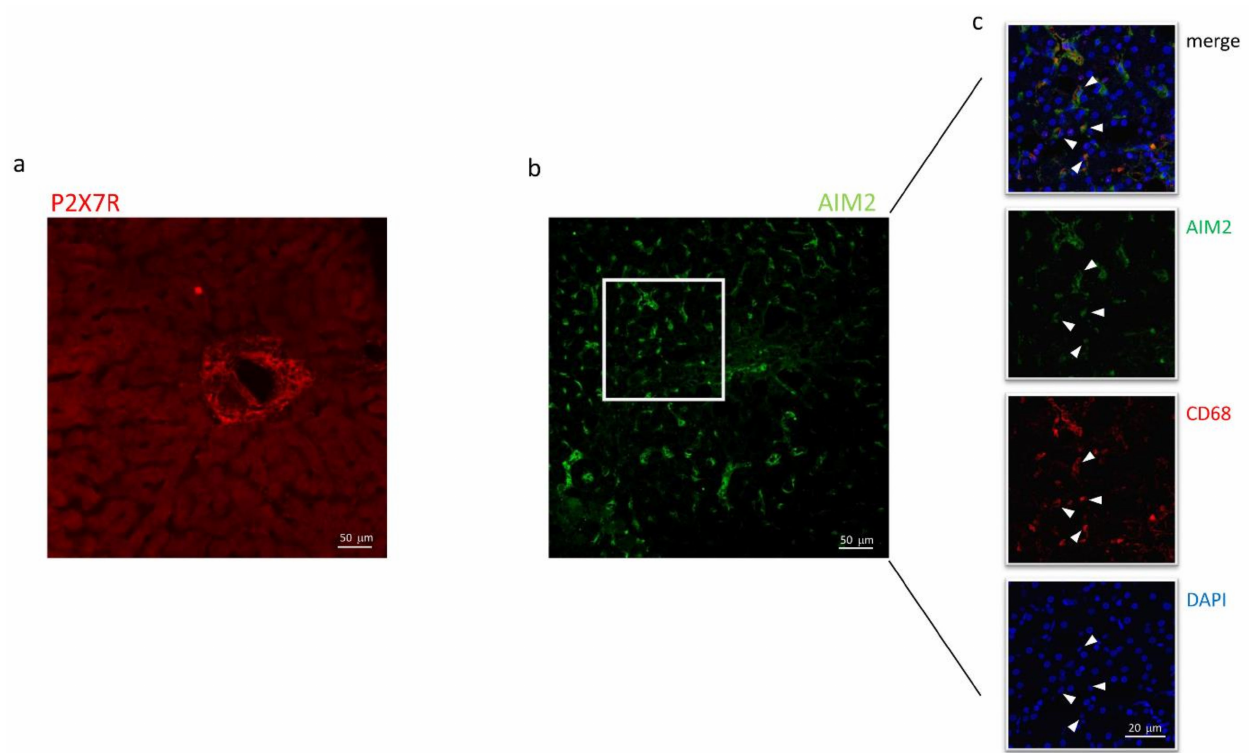
Figure 4. Confocal microscopy of liver biopsies shows P2X7R-immunostaining (red) surrounding the centrilobular vein ( a ) and AIM2-immunostaining (green), presumably near sinusoids ( b ). White arrows indicate double-stained cells. Confocal acquisitions of double staining experiments confirm AIM2 expression in Kupffer (CD68 + ) cells ( c ). White square in ( b ) points out the portion of the image analyzed in ( c ). The image is representative of experiments performed in 6 biopsies for each group; P2X7R and AIM2 localization was confirmed irrespective of the liver